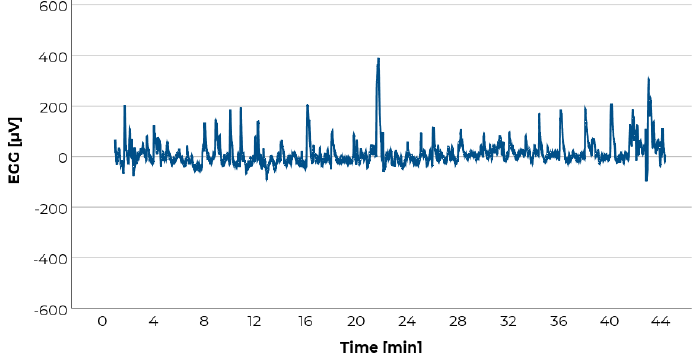
Figure 8. Exemplary raw electrogastrography (EGG) data of a participant during a 44-min drive as passenger on a German Autobahn. Like with EDA (see Figure 6), the peaks in the chart indicate artifacts. In EGG data, these derive mainly from participant’s movements.